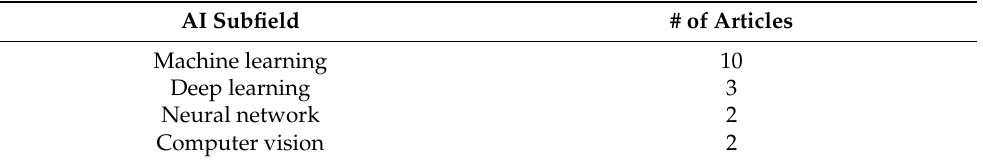
Table 8. AI Subfields in Selected Articles. AI